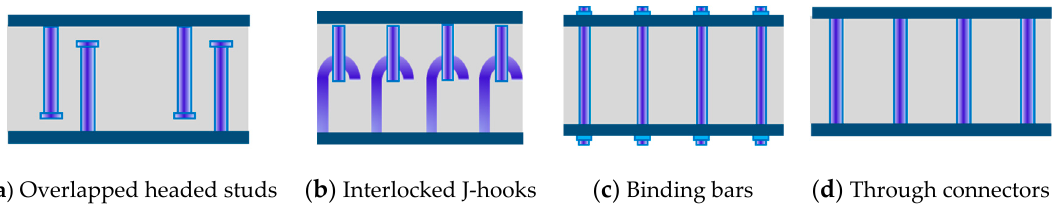
Figure 3. Main types of connectors used in steel-concrete-steel (SCS) composite walls.